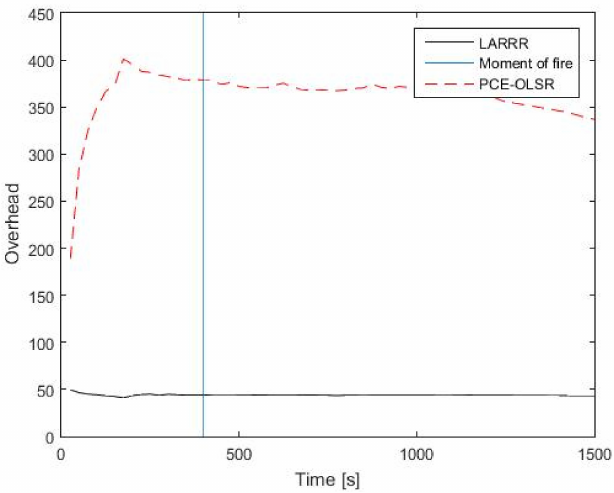
Figure 14. RO results between LARRR and PCE-OLSR.